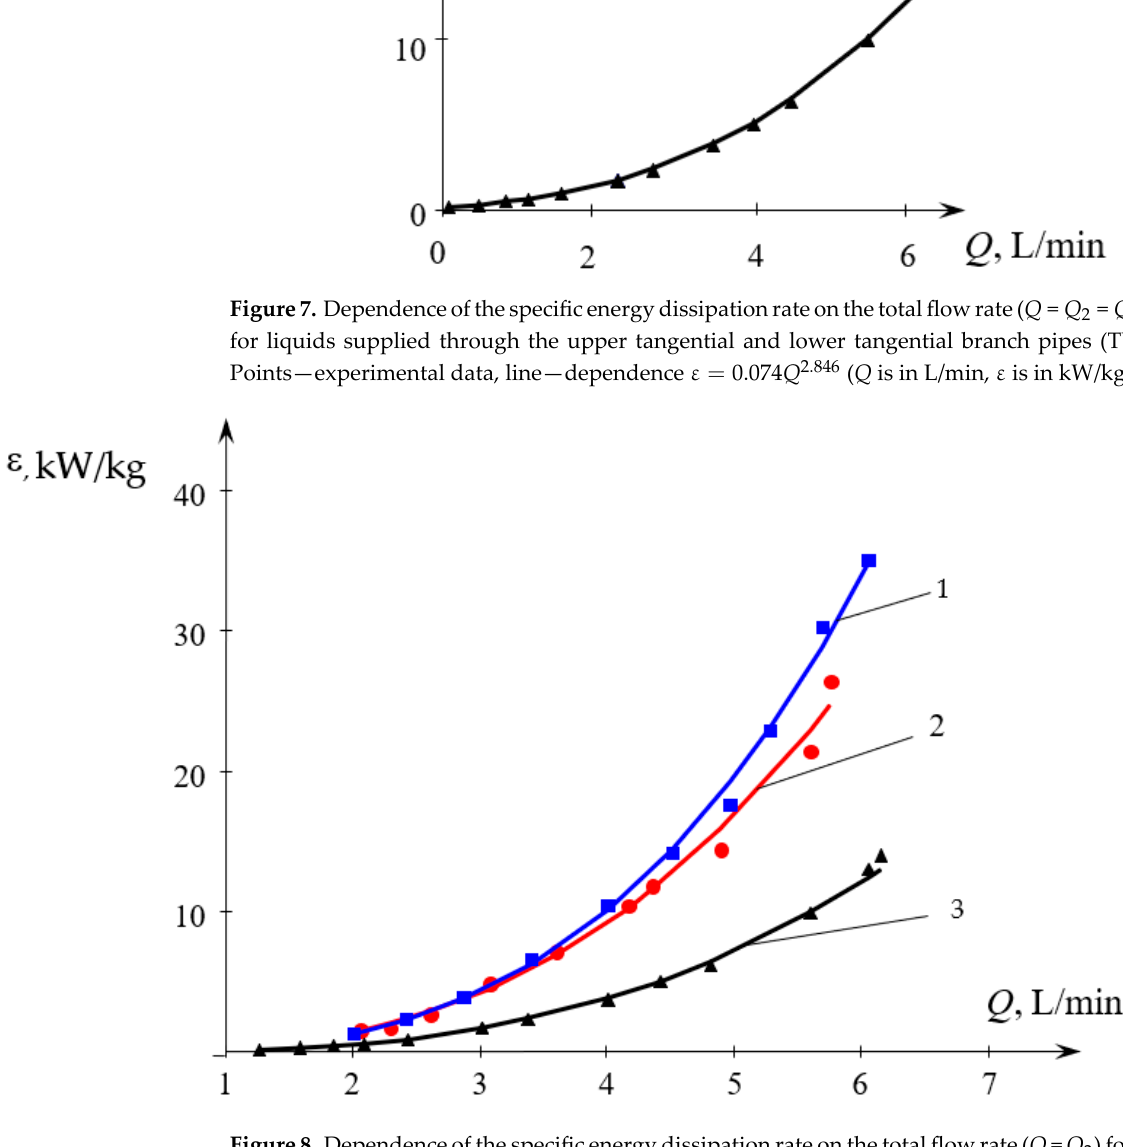
Figure 8. Dependence of the specific energy dissipation rate on the total flow rate ( Q = Q 2 ) for various methods of liquids supply into the MRISF ‐ 2: 1—(TU1, Ax); 2—(TU1, TU2); 3—(TU1, TL2).